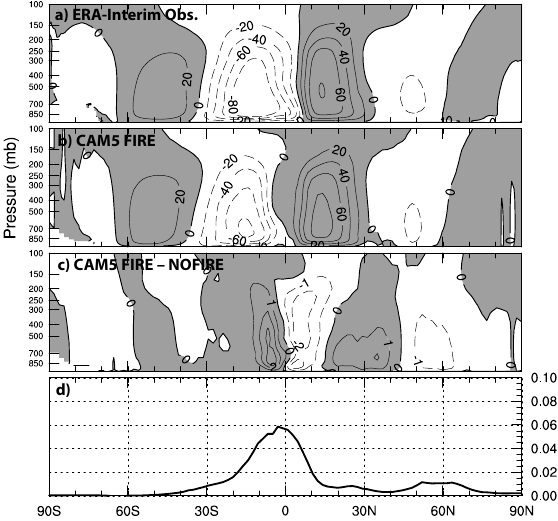
Fig. 7. Zonal-mean (annual) mass streamfunction ( ψ ) derived from (a) ECMWF ERA-interim observations, (b) CAM5 simulations in- cluding fire aerosols, and (c) the difference between the FIRE and NOFIRE simulations. Units are in 10 9 kgs − 1 for all plots. Con- tour intervals vary. Shaded regions indicate northward transport, un- shaded regions are southward transport. (d) is the zonally-averaged AOD.